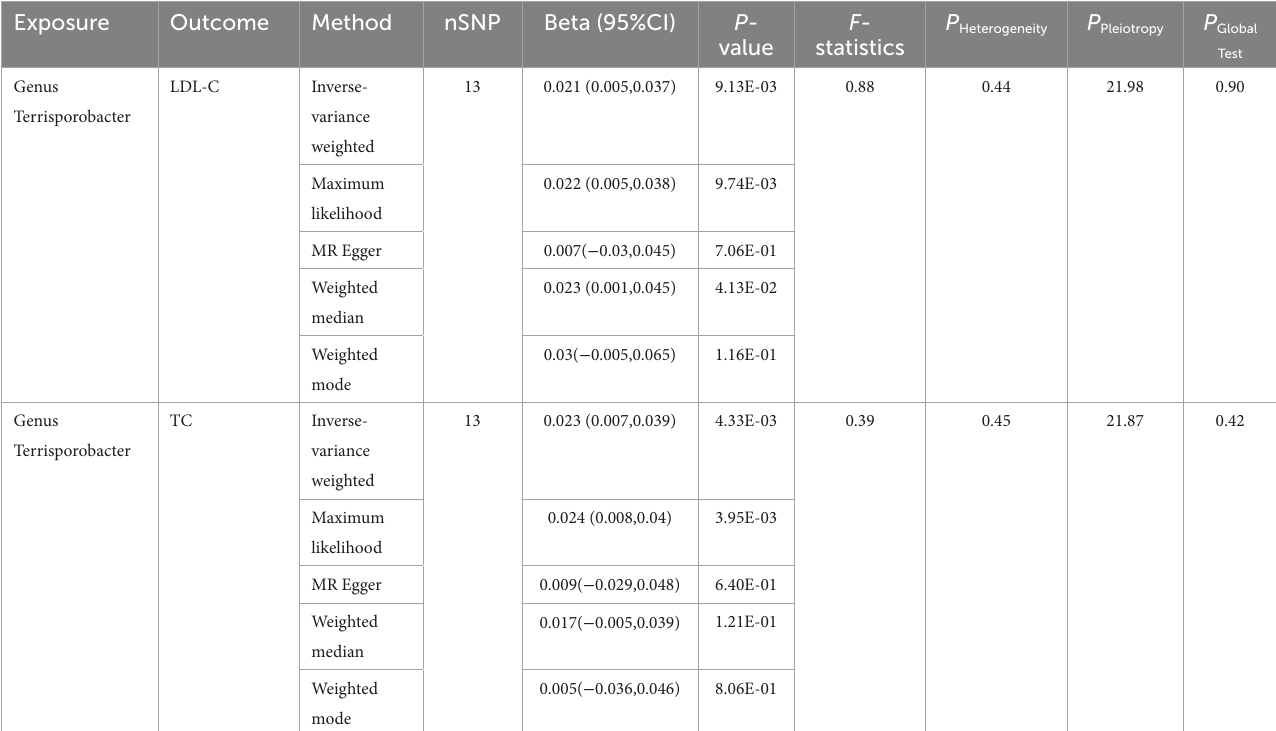
TABLE 3 Replication of the causalities from Terrisporobacter to LDL-C and